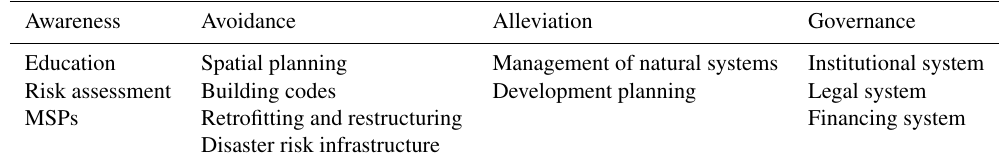
Table 1. Relevant parameters for each dimension of